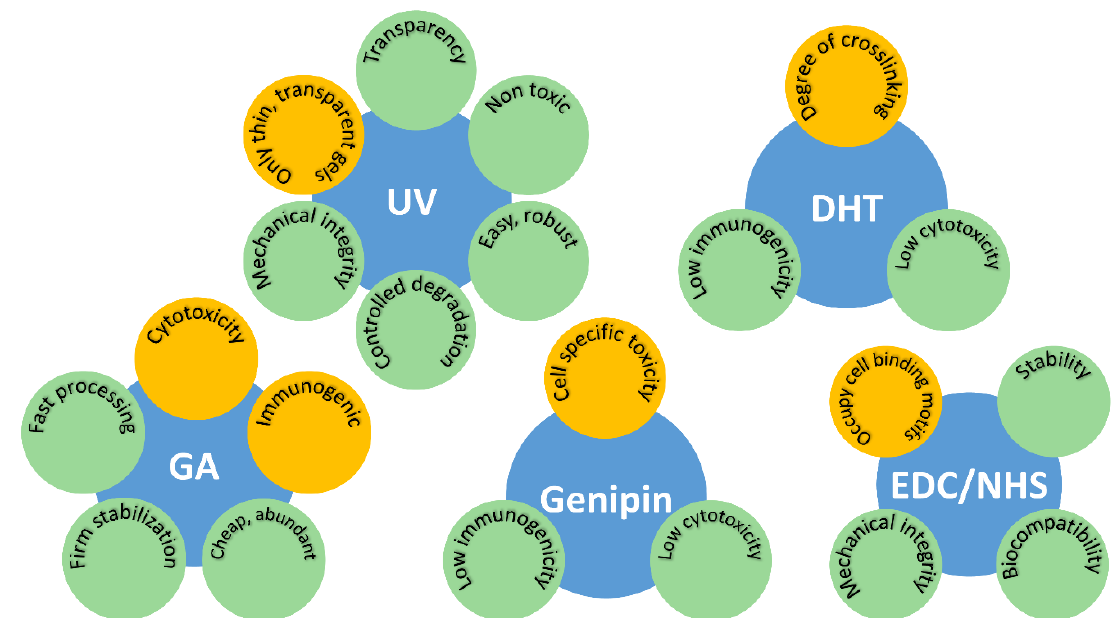
Figure 4. Schematic representation summarizing the pros (green) and cons (orange) of commonly used crosslinking techniques and chemical additives in terms of their impact on hydrogel characteristics.